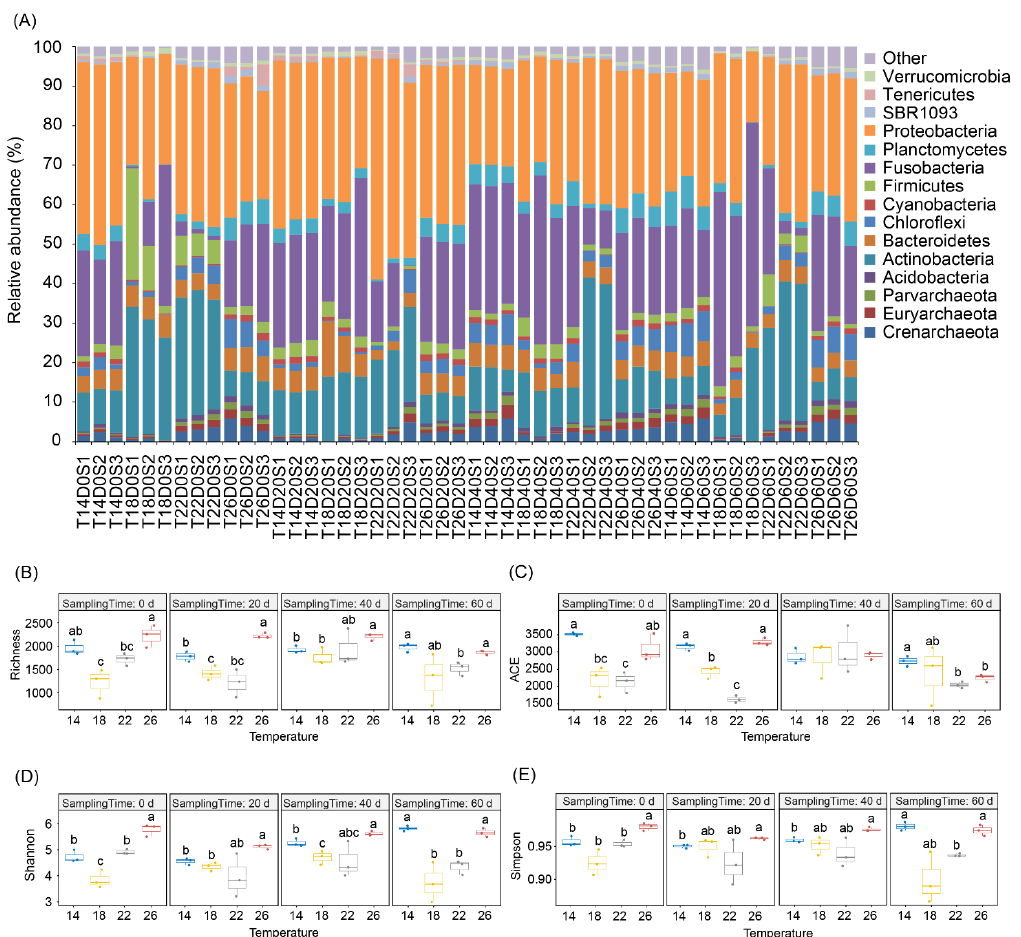
Figure 2. Dominant phylum compositions ( A ); and α -diversity indices ( B – E ) of Percocypris pingi gut microbiota at different culture temperatures. ( B ) Richness index; ( C ) ACE index; ( D ) Shannon index; and ( E ) Simpson index. Dots in the boxplots indicate values measured in samples. Different letters above the boxes indicate significant differences ( p < 0.05).